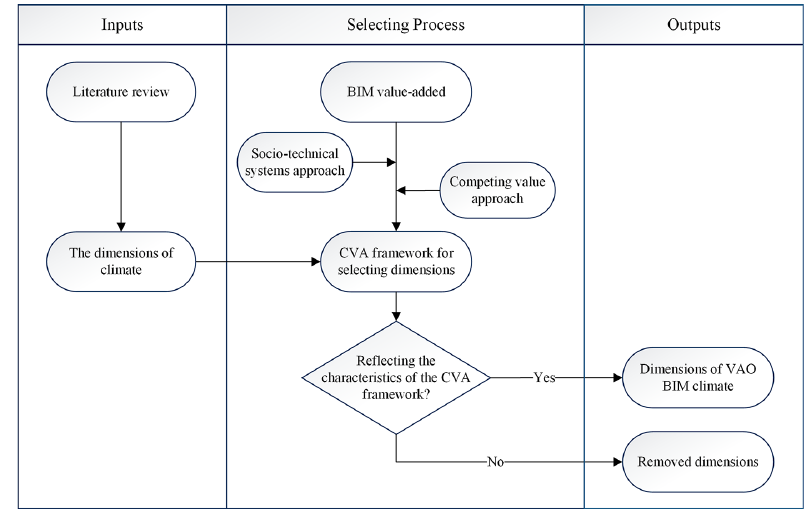
Figure 1. Overview of selecting VAO BIM climate